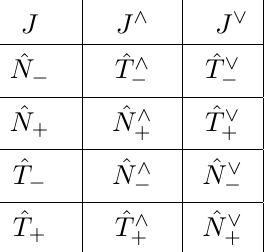
Table 3 . Action of the mirror symmetry maps relevant to characterize N = 2